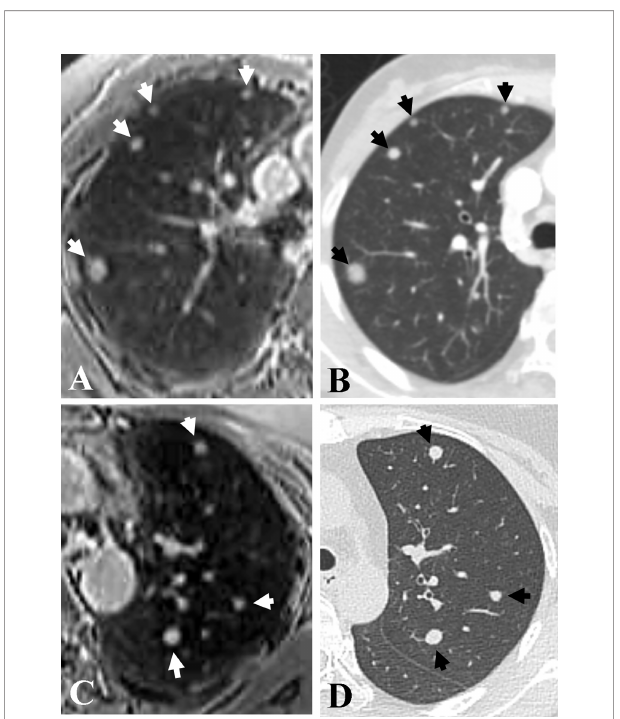
FIGURE 2 | Representative axial images of accelerated spiral 3D UTE (A, C) and CT (B, D) for the detection of pulmonary metastasis. Seven nodules (arrows; range, 3.5 mm – 10.6 mm in diameter) are detected in both upper lobes in a 38-year-old patient with bilateral breast cancer. The overall image quality rating for spiral 3D UTE images (A, C) was excellent.